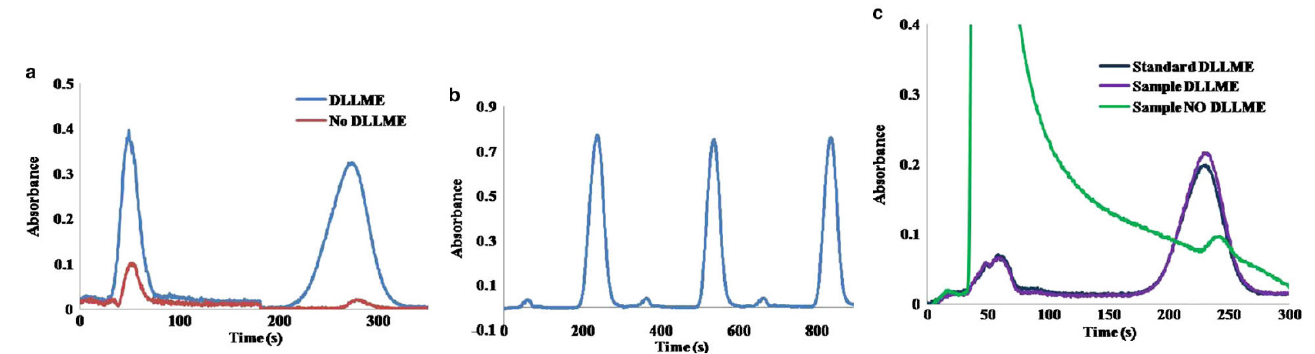
Figure 2. ( a ) Chromatogram showing the separation of benzo(a)pyrene (25 µ g L − 1 , 273 s) from the phenol (50 s, 1 mg L − 1 ) without and with DLLME; ( b ) Three replicates of the injection of a 50 µ g L − 1 benzo(a)pyrene standard using ACN/H 2 O 70/30 v / v ; ( c ) Chromatograms corresponding to the direct injection of tap water spiked with 15 µ g L − 1 benzo(a)pyrene spiked tap water after DLLME, and a standard containing 15 µ g L − 1 of benzo(a)pyrene using DLLME. Mobile phase, ACN/H 2 O (70/30 v / v )